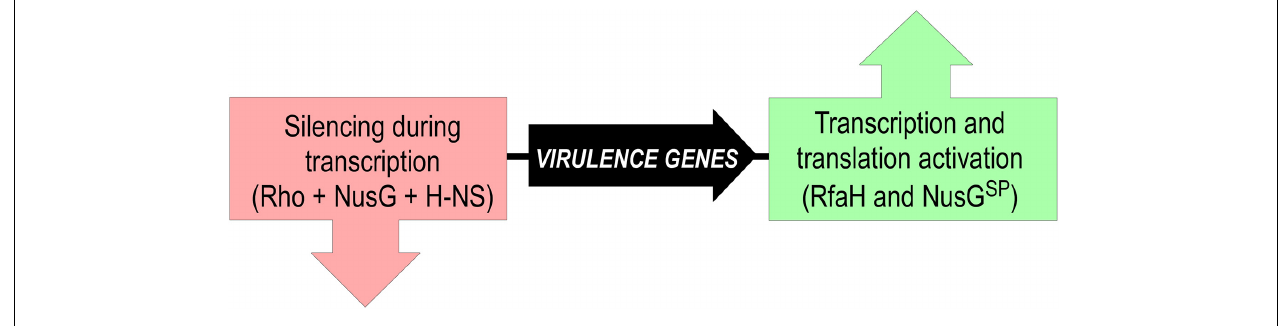
FIGURE 8 | Silencing and counter-silencing of virulence genes by NusG-like